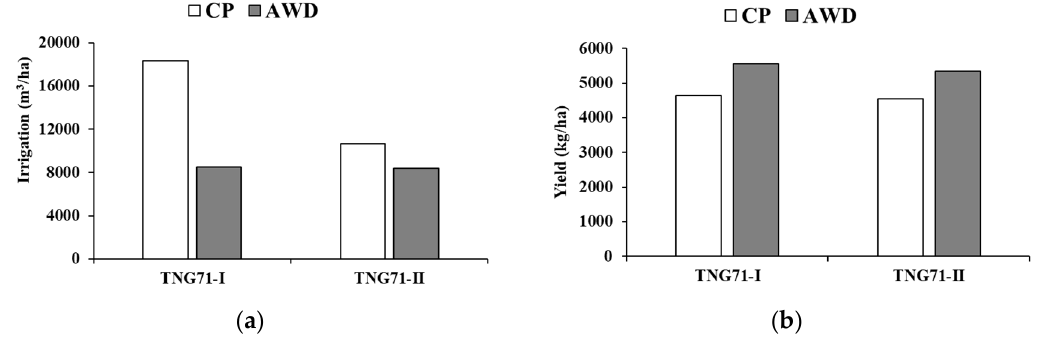
Figure 9. The cultivation calendar of rice cultivar TNG71 and the variation of water level and rainfall during days after transplant under different water treatments in ( a ) the first crop season; and ( b ) the second crop season.